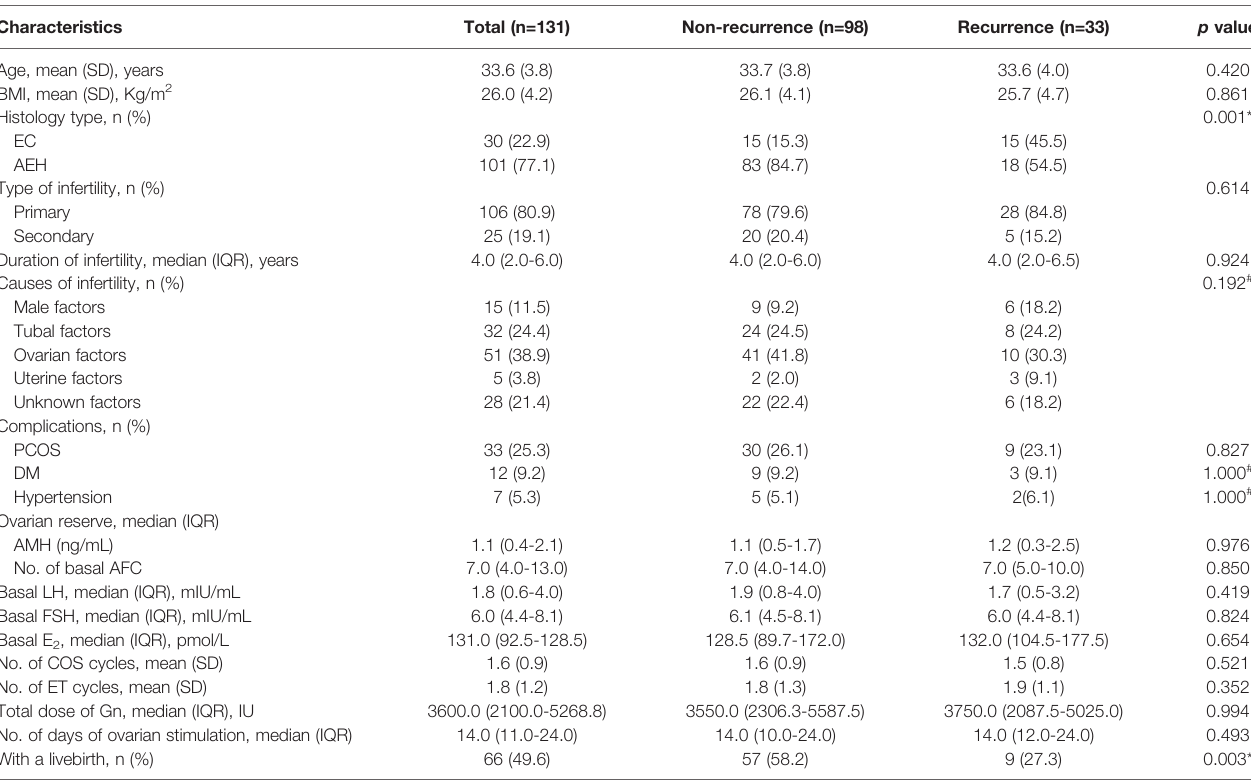
TABLE 1 | Baseline characteristics of the analysis